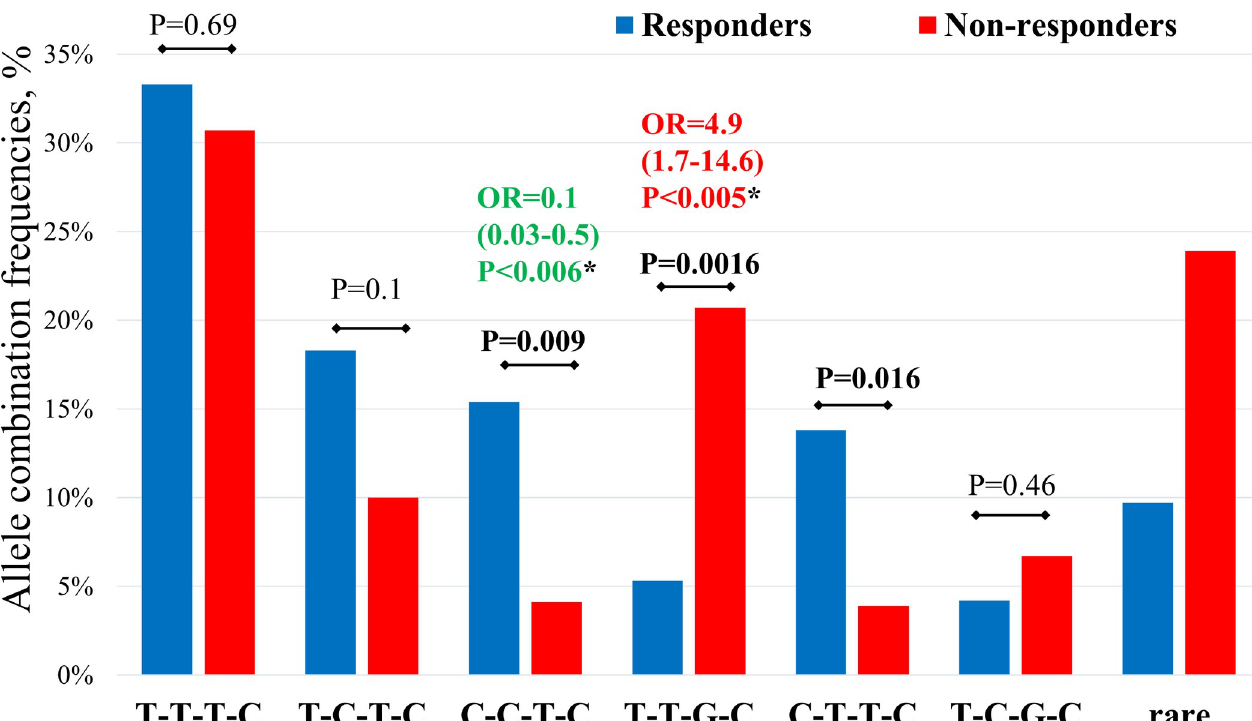
Fig 1. The comparison of frequencies of estimated allelic combinations, constructed from SOST , PTH , FDPS , and GGPS1 gene variants, in responders and non-responders groups of patients with postmenopausal osteoporosis after 12 months to treatment with BPs. ( � )–compared with reference